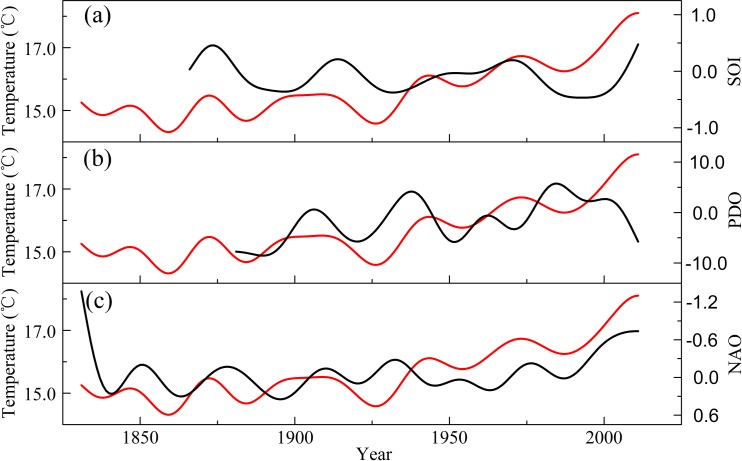
Comparison between our reconstructed temperature and the large-scale atmospheric-oceanic circulations (SO, PDO and NAO).These were smoothed using a 20-year low-pass filter.